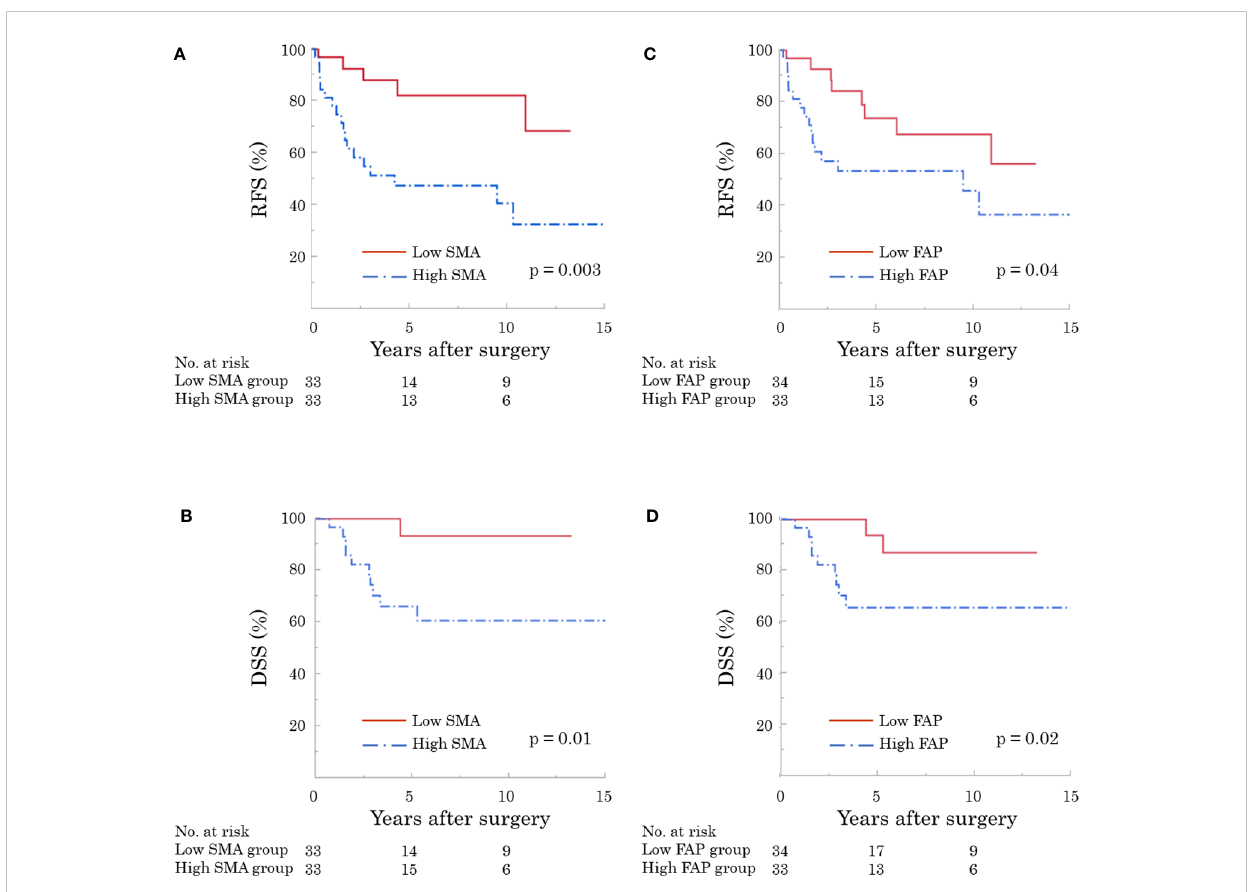
FIGURE 4 Recurrence-free (RFS) and disease-speci fi c survival (DSS) according to expression of cancer-associated fi broblasts (CAF). The high a -smooth muscle actin ( a -SMA) group had signi fi cantly worse RFS [ (A) p = 0.003] and DSS [ (B) p = 0.01]. In addition, patients with high fi broblast activation protein (FAP) showed signi fi cantly worse RFS [ (C) p = 0.04] and DSS [ (D) p = 0.02].